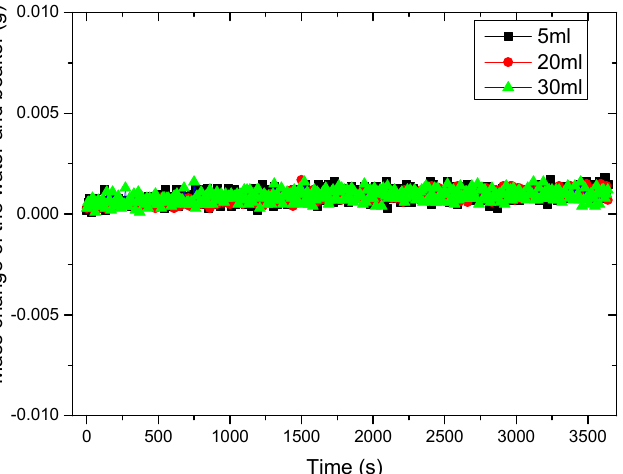
Figure 5. Mass change of the water and beaker with different liquid volumes.